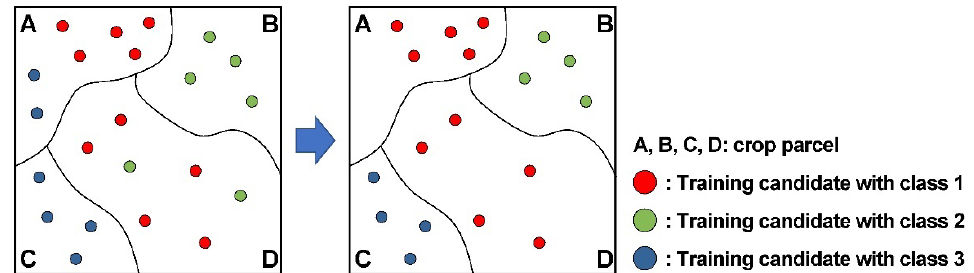
Figure 5. An illustration of the third constraint on updating the initial training candidates using the representativeness of pseudo-labels in a parcel unit.